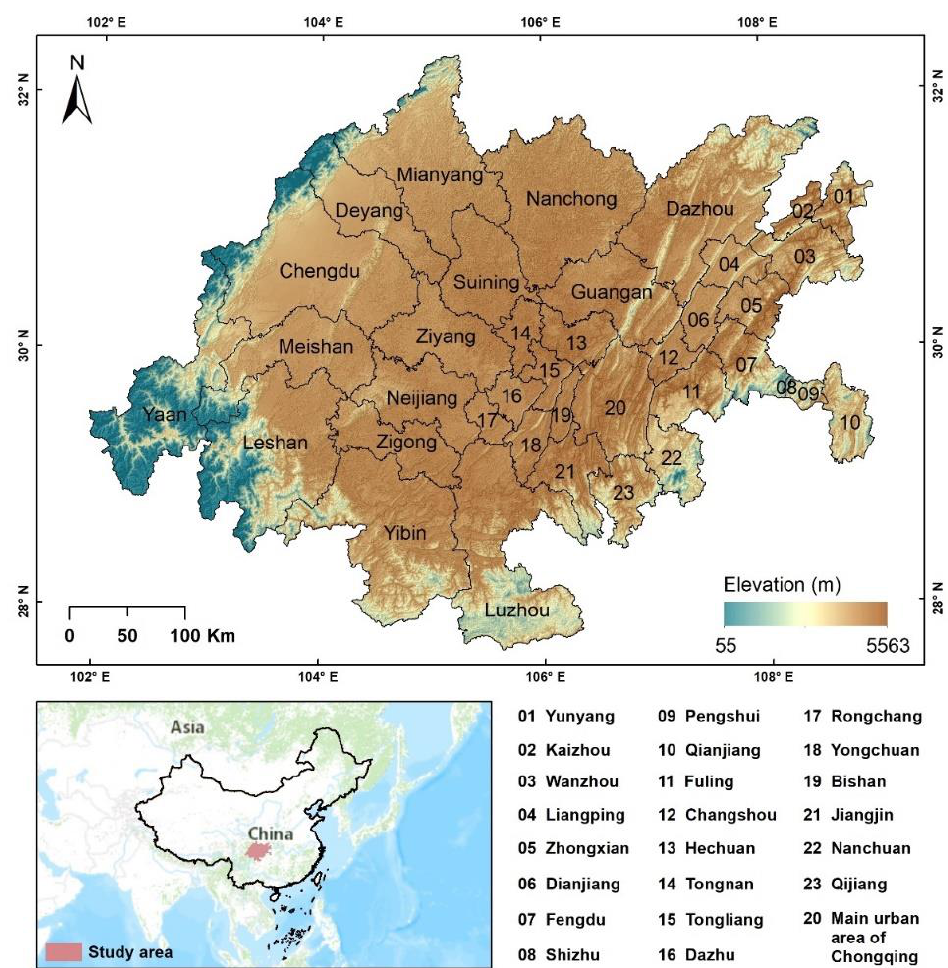
Figure 1. Location of the study area and its 38 basic units.